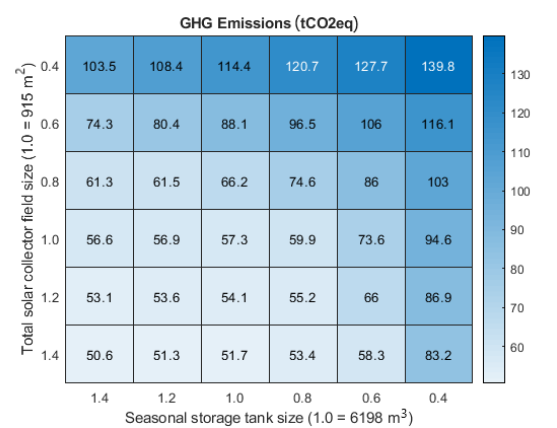
Figure 9. GHG emissions for different sizes of solar collector field and seasonal storage